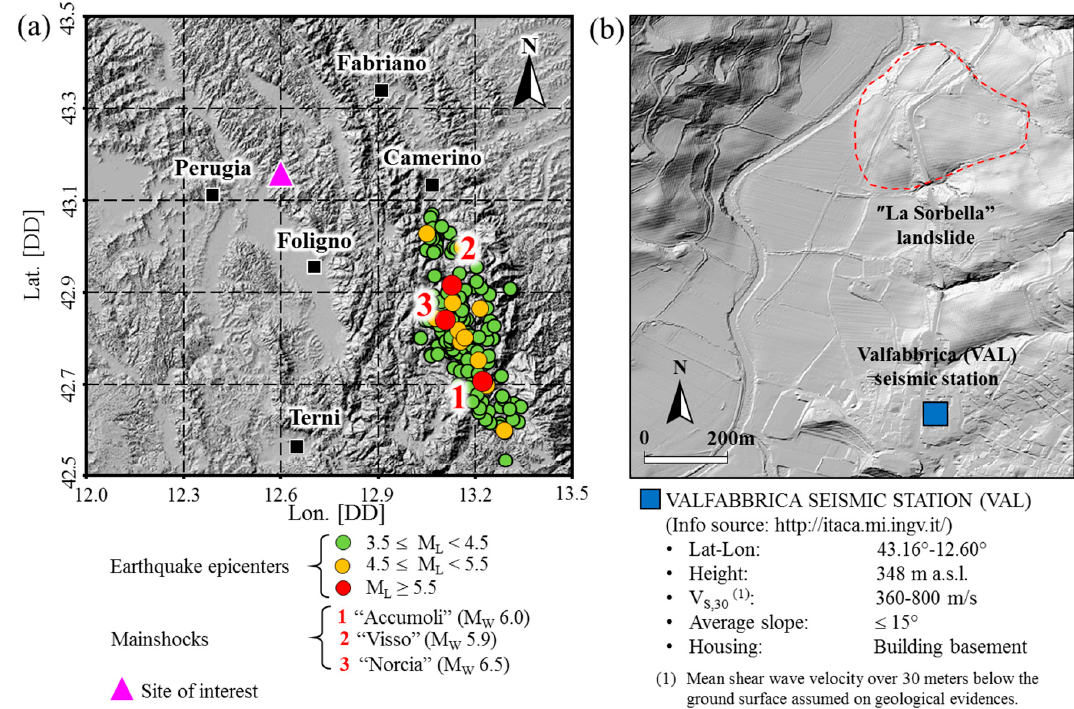
Figure 3. ( a ) Map of central Italy with position of the “Sorbella” landslide and indication of epicenters of seismic events with M L > 3.5 occurring in the period August–November 2016; ( b ) zoom of the site of interest with indication of the landslide and of the closest accelerometric station of “Valfabbrica” (Digital Terrain Model from “Ministero dell’Ambiente e della Tutela del Territorio e del Mare”).